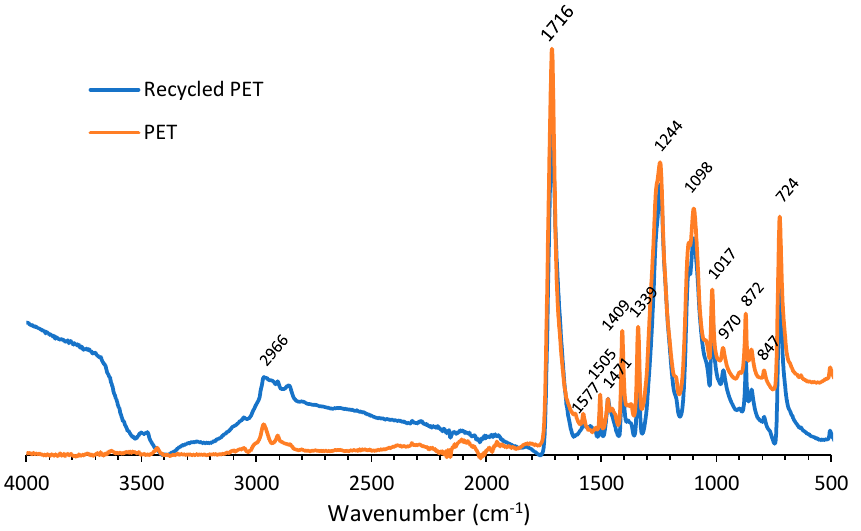
Figure 7. IR spectra of recycled and virgin PET.